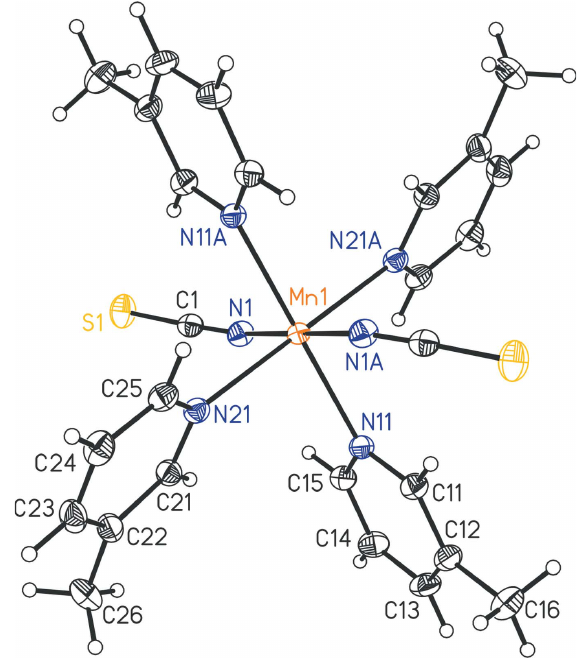
Figure 3 The molecular structure of compound 1 with displacement ellipsoids drawn at the 50% probability level. [Symmetry code: (A) 1 (cid:3) x , 1 (cid:3) y , 1 (cid:3) z .]